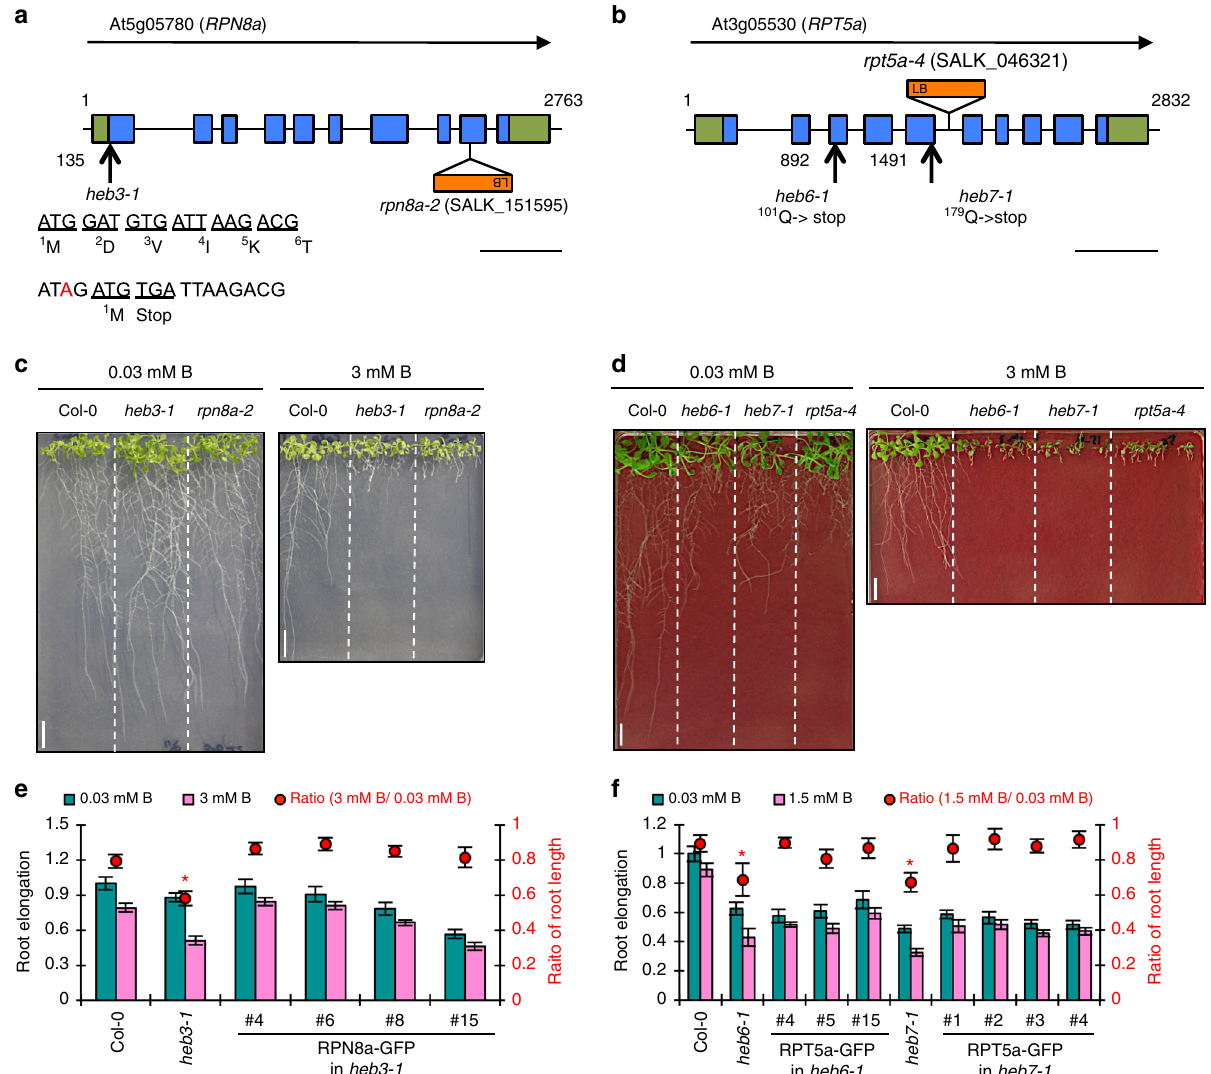
Fig. 2 RPN8a is the gene responsible for heb3-1 and RPT5a is the gene responsible for both heb6-1 and heb7-1 . a , b Gene structure and T-DNA insertion sites in RPN8a ( a ) and RPT5a ( b ). Blue and green boxes indicate coding and untranslated regions, respectively. Scale bars, 500 bp. c , d Short-root phenotypes of T-DNA-inserted mutants of RPN8a ( c ) and RPT5a ( d ) grown under normal- (left) and high-B (right) conditions for 14 days. Scale bars, 1 cm. e , f Sensitivity of root growth to high-B stress with GFP-fused RPN8a introduced into heb3-1 ( e ) and GFP-fused RPT5a introduced into heb6-1 and heb7-1 mutants ( f ). Sensitivity was assayed by the transplant method (see Methods section). Values for root elongation are ratios relative to the value of Col-0 under 0.03 mM B conditions. Red circles represent the ratio relative to the value under 0.03 mM B conditions ( n = 12 – 18, average ± s.e.m.; * P < 0.05, compared with Col-0, Student ’ s t -test). There were no signi fi cant differences in the sensitivity to high-B stress between Col-0 and any of the transgenic